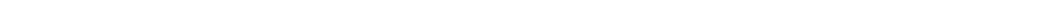
(see fi gure on previous page) Fig. 3 CRNDE-h mediated the role of CRC cell-exosome in promoting Th17 cell differentiation. A PBMCs isolated from healthy subjects were cultured under the condition of Th17 cell differentiation induction and treated with CRC cell-exosome (SW480-E, HT29-E, and LOVO-E). Then, the proportion of Th17 cells was detected by fl ow cytometry, and the content of IL-17 in the cell culture supernatant was detected by ELISA assay. B Healthy PBMCs were cultured under the condition of Th17 cells differentiation induction and treated with exosome derived by CRC cells (SW480, HT29, and LOVO) transfected with si-CRNDE-h (or si-control). Then, the proportion of Th17 cells was detected by fl ow cytometry, and the content of IL-17 in the cell culture supernatant was detected by ELISA assay. C Healthy PBMCs were transfected with lentiviral (LV) vectors carrying CRNDE-h (LV- CRNDE-h) or green fl uorescent protein (LV-GFP), and then cultured under the condition of Th17 cell differentiation induction. The proportion of Th17 cells was detected by fl ow cytometry and the content of IL-17 in the cell culture supernatant was detected by ELISA assay. E: exosome. * p < 0.05, ** p < 0.01 vs. NCM460-E, si-control-E, or